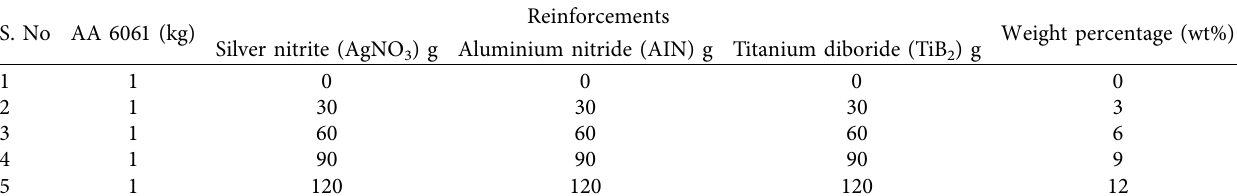
Table 1: Weight percentages of AA6061 and its reinforcements.